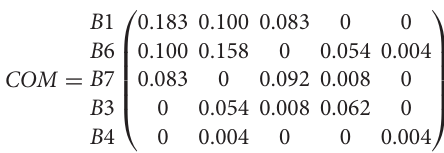
variables in the “best” feature subsets: